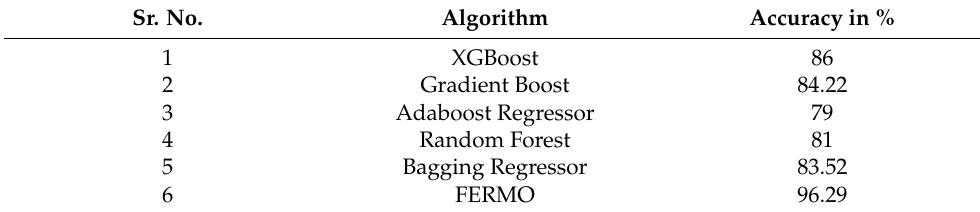
Table 6. Ensemble regression algorithm at level zero (L-1).